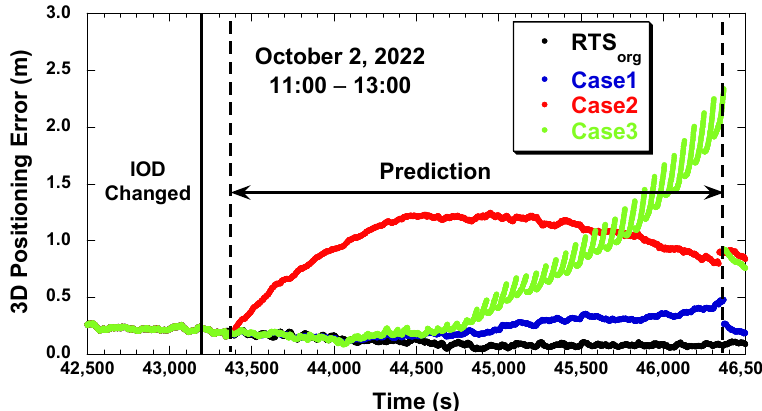
Figure 11. PPP positioning error with different prediction methods (2 October 2022). Figure 12 compares the PPP positioning error RMSs from different prediction intervals.